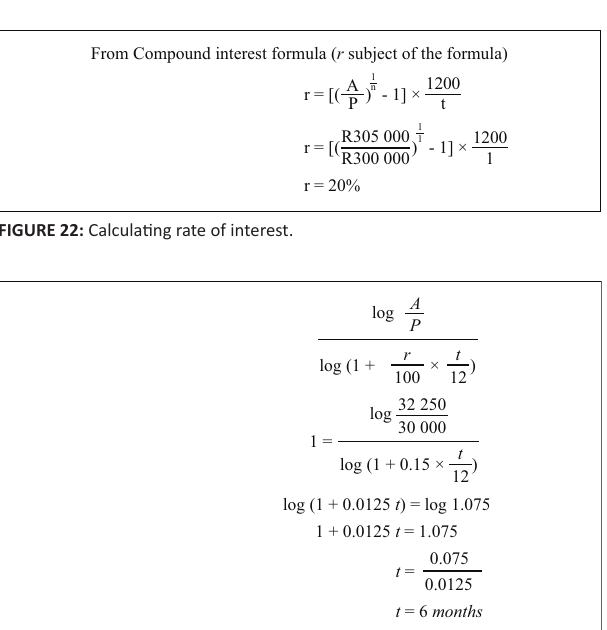
FIGURE 21: Compound interest – Mathematics versus accounting.